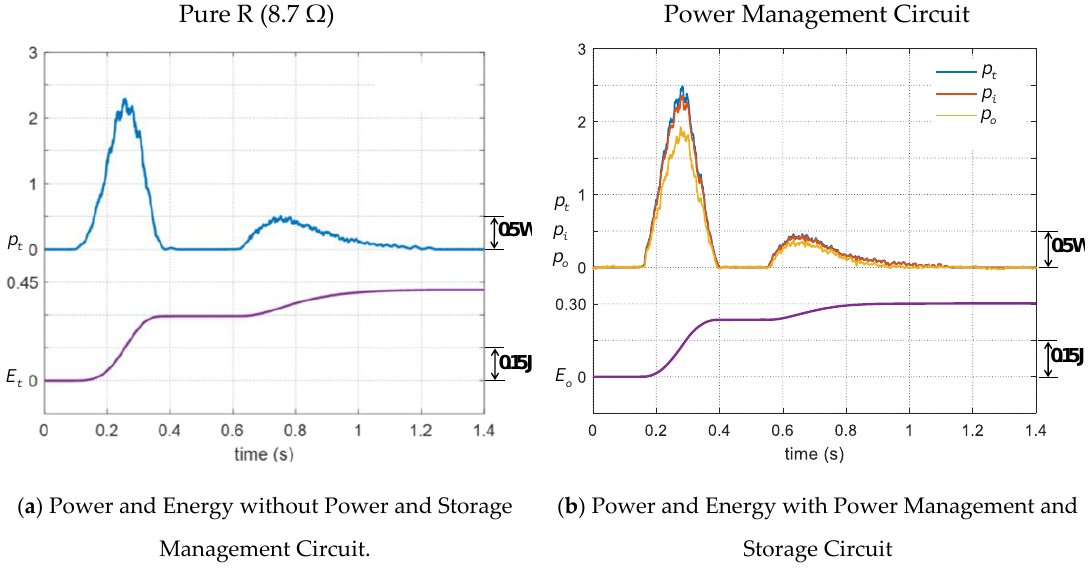
Figure 20. Experimental result showing the operation of the power management system regarding the process of power conversion and energy storage; 𝑃 𝑡 and 𝐸 𝑡 are power and energy outputs of the generator; 𝑃 𝑖 is power output of the rectifier circuit; 𝑃 𝑜 and 𝐸 𝑜 are power and energy outputs of the buck-boost circuit. Table 9. Performances of power management and storage circuit with Genpath prototypes II and 12-V-DC generator.